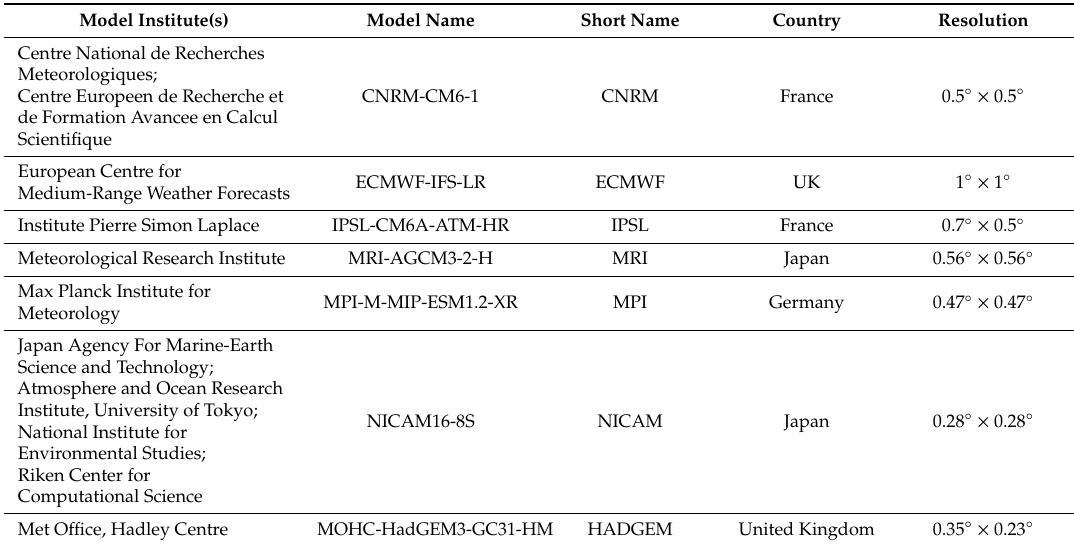
Table 1. Brief description of the global climate models (GCMs) used in this study.